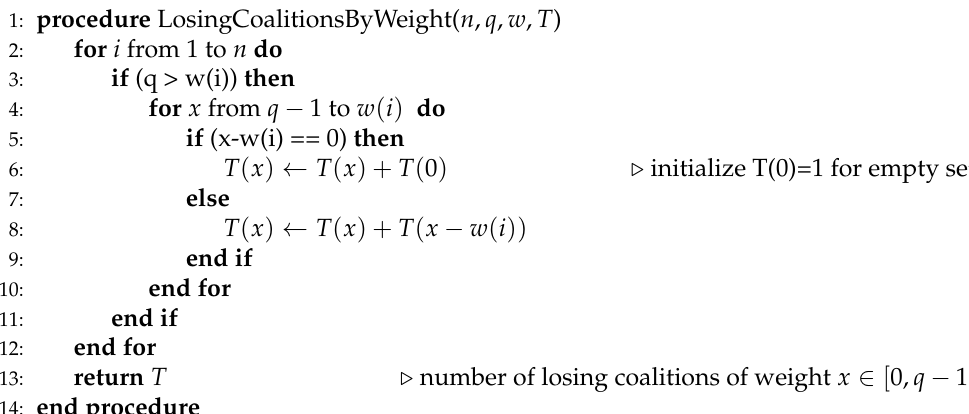
Algorithm 1 Generalized counting of number of losing coalitions per